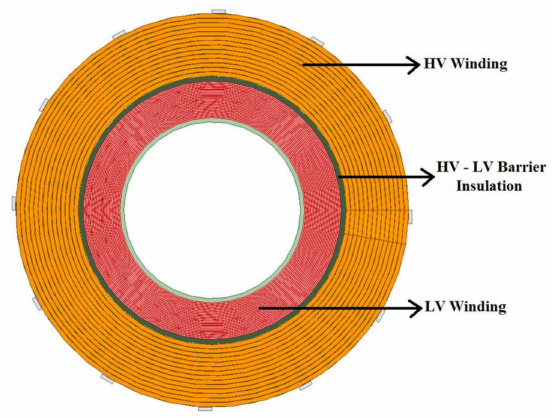
Figure 10. Top view of the winding for a single